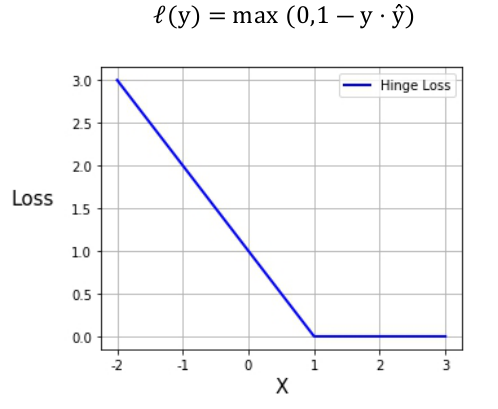
Figure 6. Hinge Loss function curve